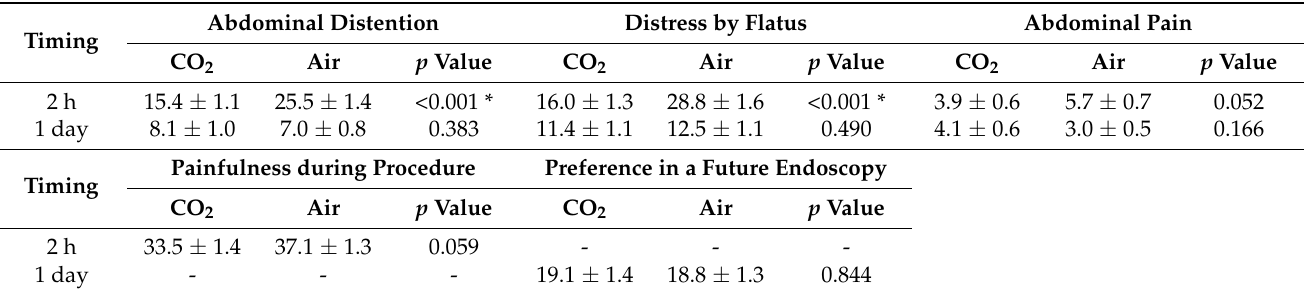
Table 2. Results of examinees’ questionnaires.